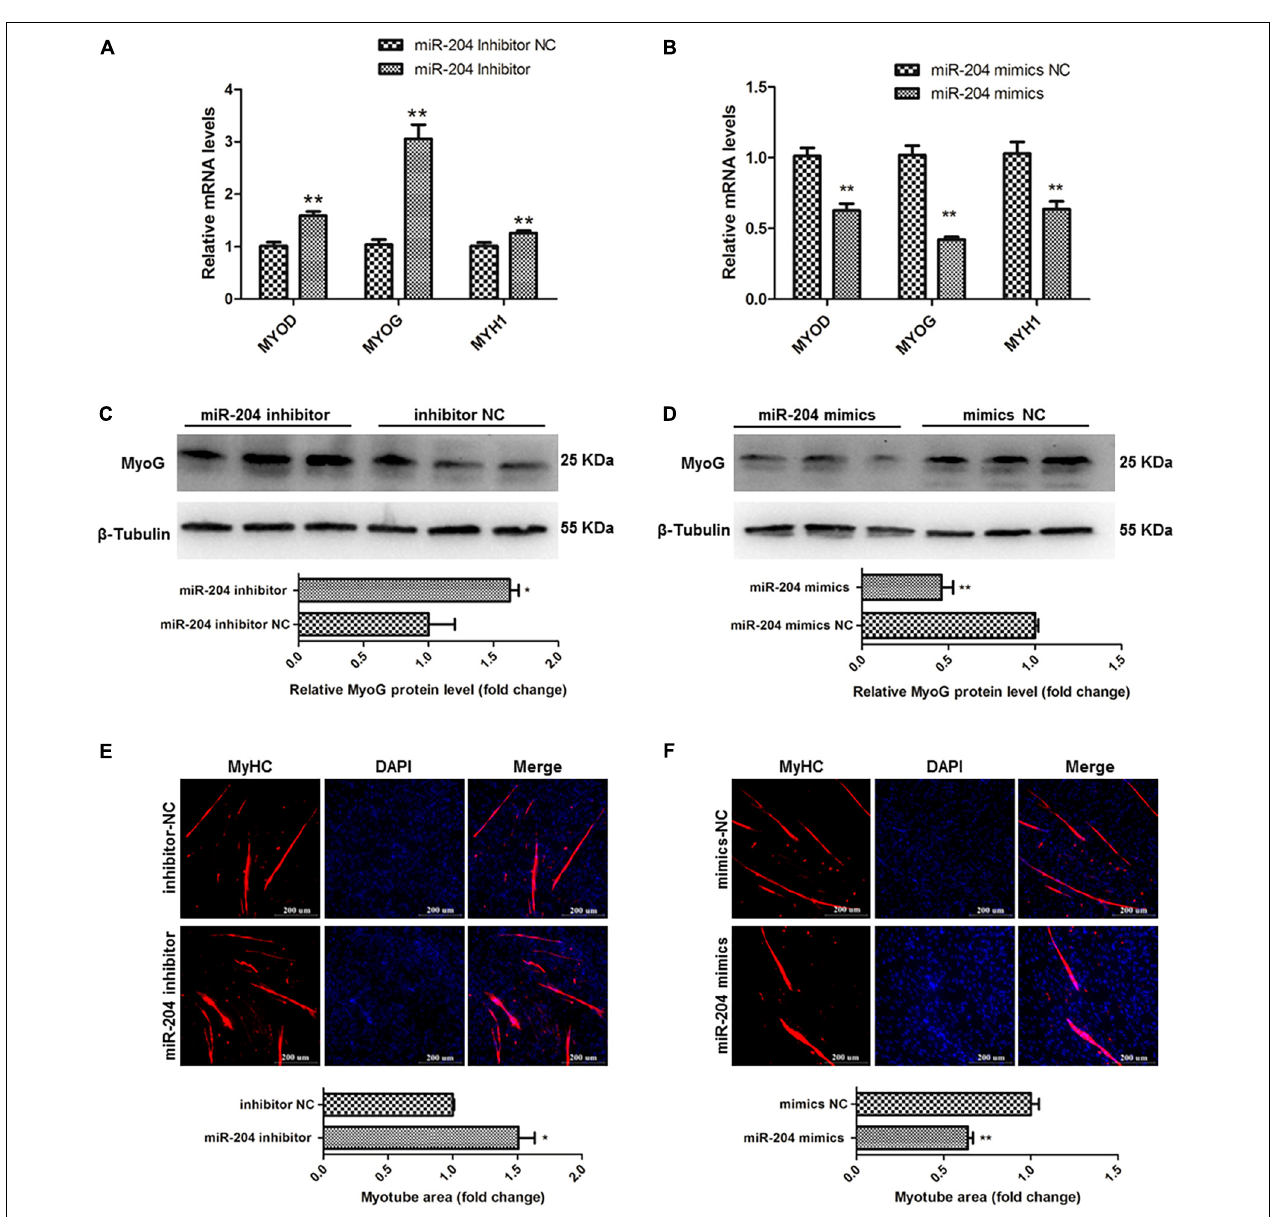
FIGURE 6 | MiR-204 represses the differentiation of SMSCs in chicken. (A,B) Differentiation-related genes mRNA levels were determined using qPCR after SMSCs were transfected with miR-204 inhibitor or mimics. (C,D) MyoG protein levels were detected by western blot after miR-204 were interfered or overexpressed in SMSCs. (E,F) Myotube areas were calculated at 72 h after miR-204 was interfered or overexpressed in SMSCs. The scale bar represents 200 µ m. Values represent as means ± S.E.M. of three biological replicates. * P < 0.05; ** P <